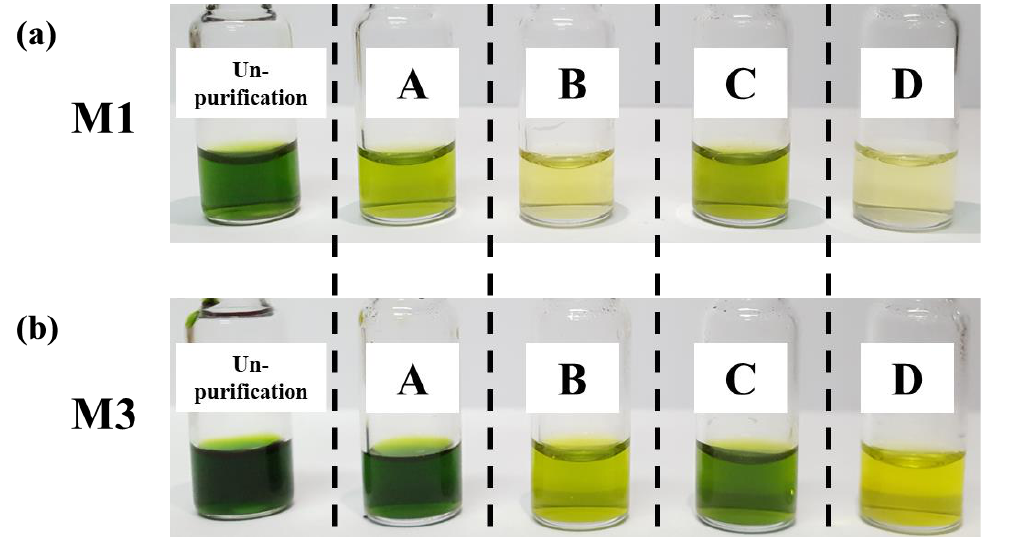
Figure 3. Colorimetric estimation of extract solutions for various purification methods. ( a ) Extraction with MeCN; ( b ) Extraction with MeCN/EA (1:1, v / v ). The methods corresponding to capital letters A to D in this figure are as follows: A, PSA d-SPE; B, PSA + GCB d-SPE; C, HLB; D, PSA + GCB d-SPE and HLB combination.